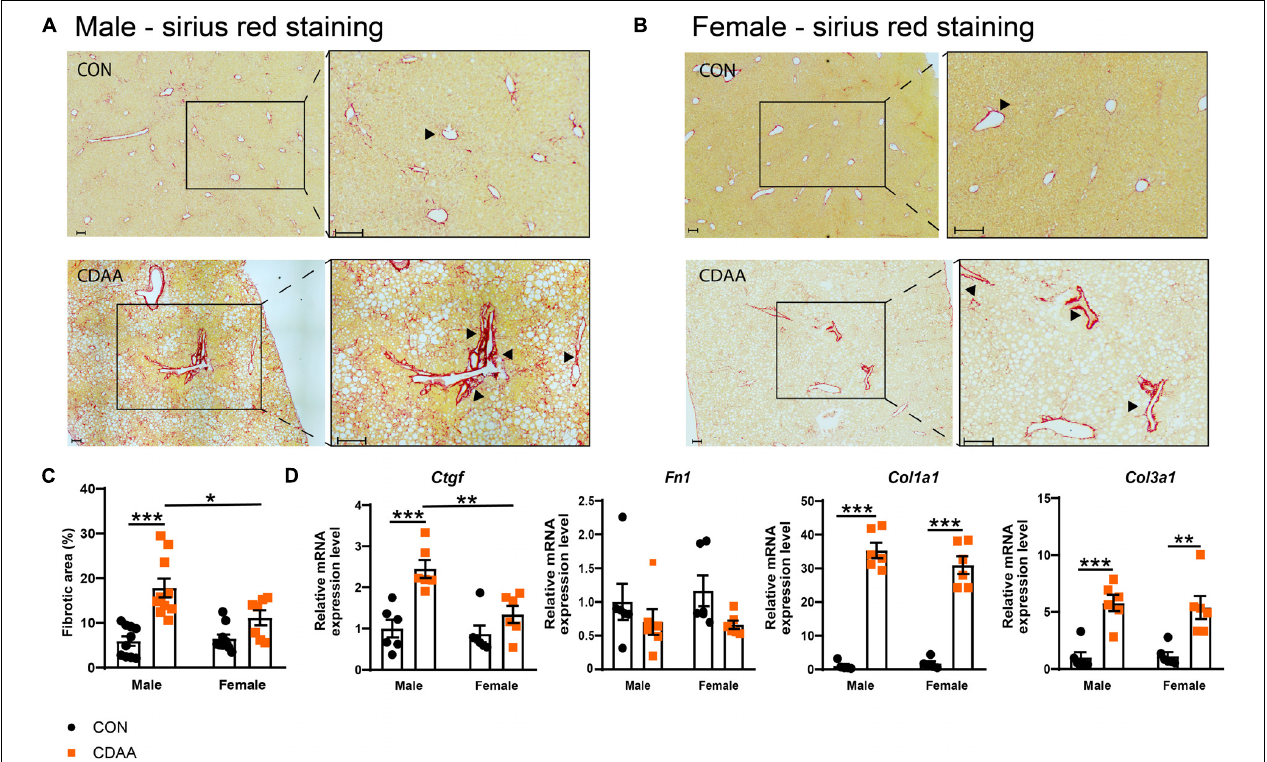
FIGURE 4 | Hepatic fibrosis in CDAA-induced NASH. Determination of the extent of liver fibrosis by histological assessment of hepatic pathological alterations on picrosirius red-stained liver sections in males (A) and females (B) , and by the extent of fibrotic area (%) (C) . qRT-PCR was performed to assess relative expression of the indicated fibrotic genes and it was normalized to the Rpl13 a gene (D) . Black arrows indicate fibrotic areas. Scale bar indicates 100 µ m. Results are shown as mean ± standard error of mean (SEM). * P < 0.05 was considered significant, ** P < 0.01 was considered significant, *** P < 0.001 was considered